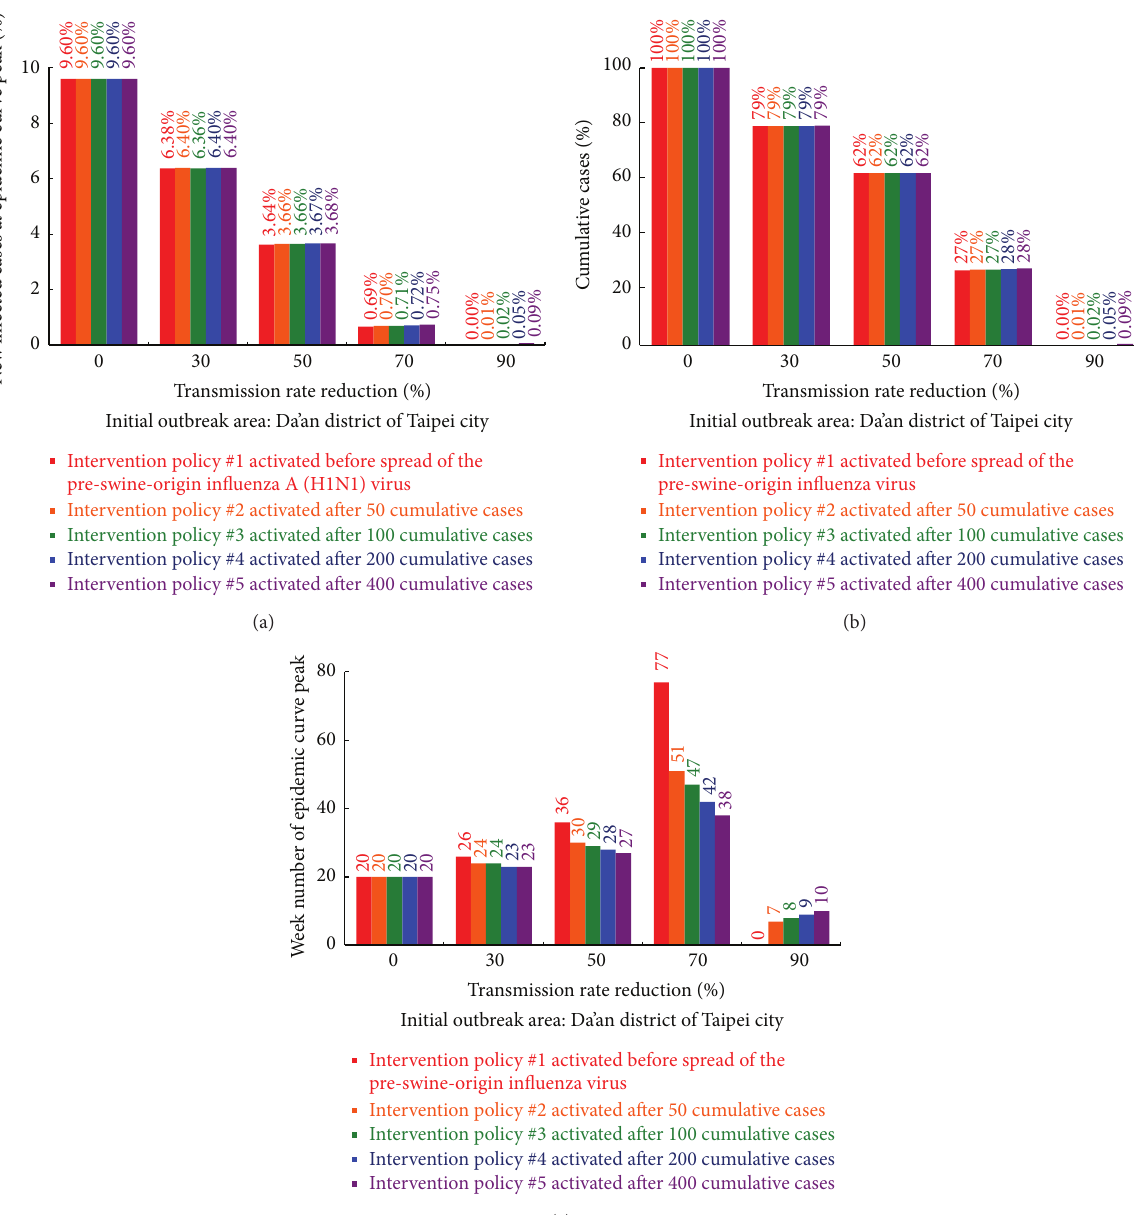
Figure 11: (a) New infected cases at epidemic curve peak according to various intervention policy scenarios at different reduced transmission rates. (b) Total number of infected cases according to various intervention policy scenarios at different reduced transmission rates. (c) Week number of epidemic curve peaks according to various intervention policy scenarios at different reduced transmission